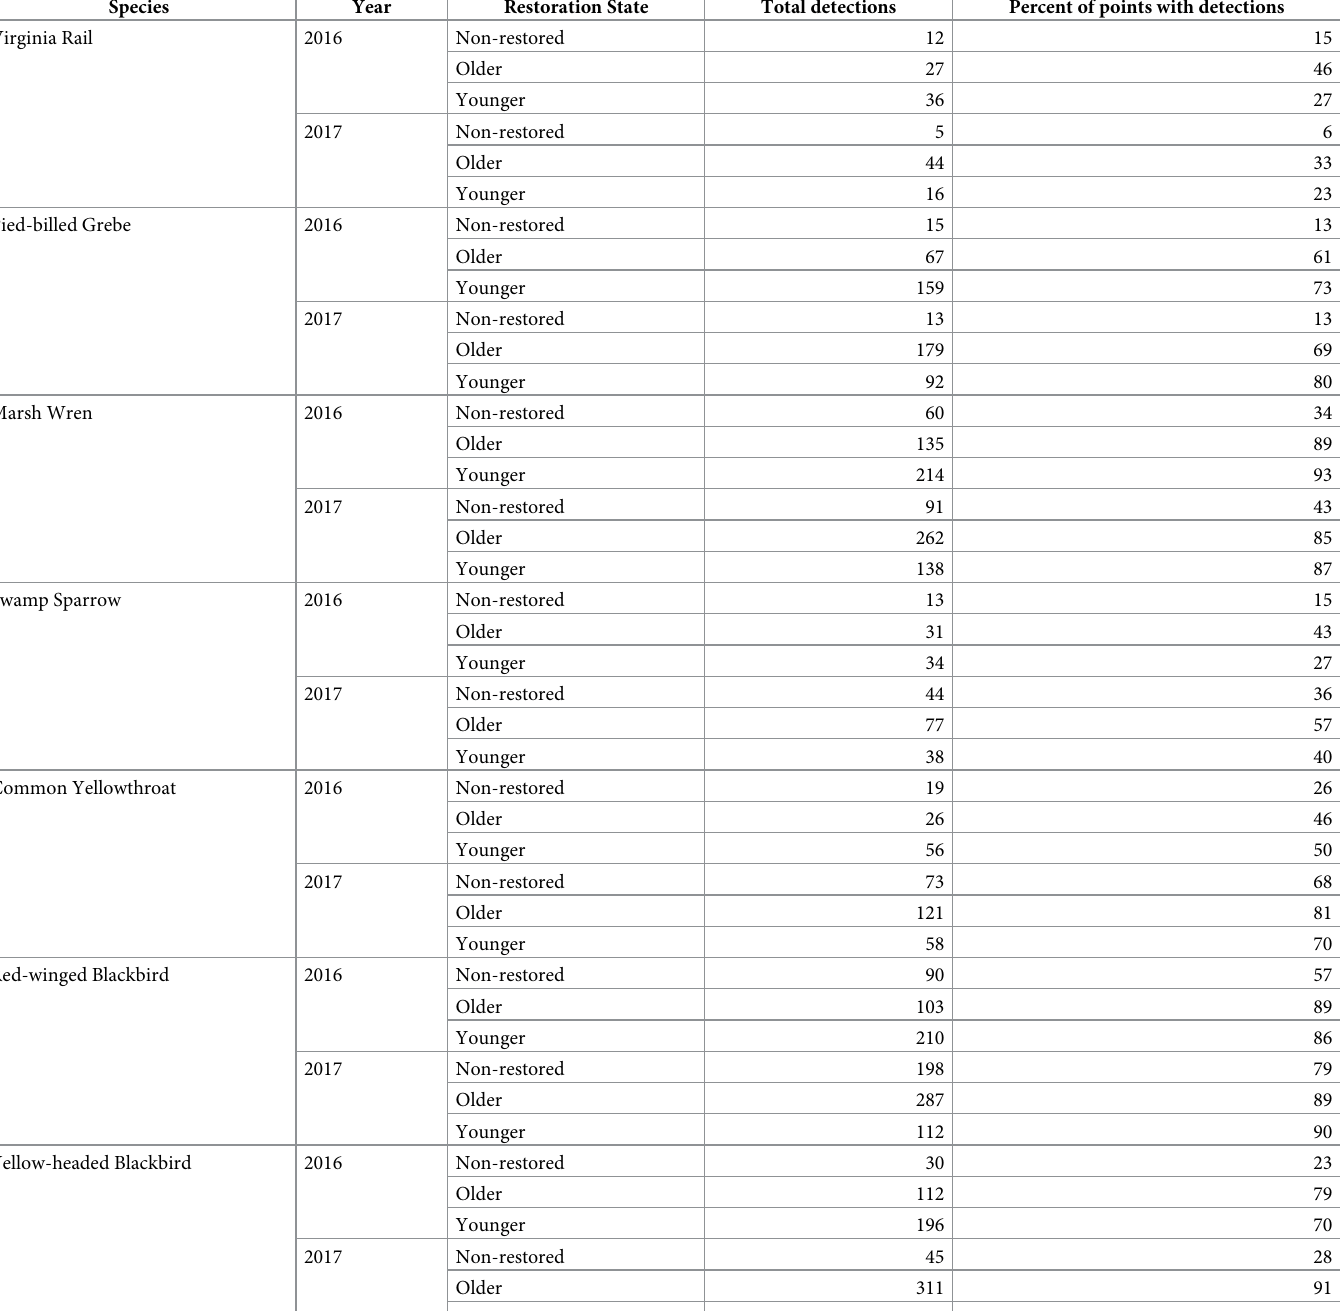
Table 1. Total number of detections and percent of points with detections of breeding marsh birds surveyed at shallow lakes in the Prairie Pothole Region of Iowa, summer 2016 and 2017.